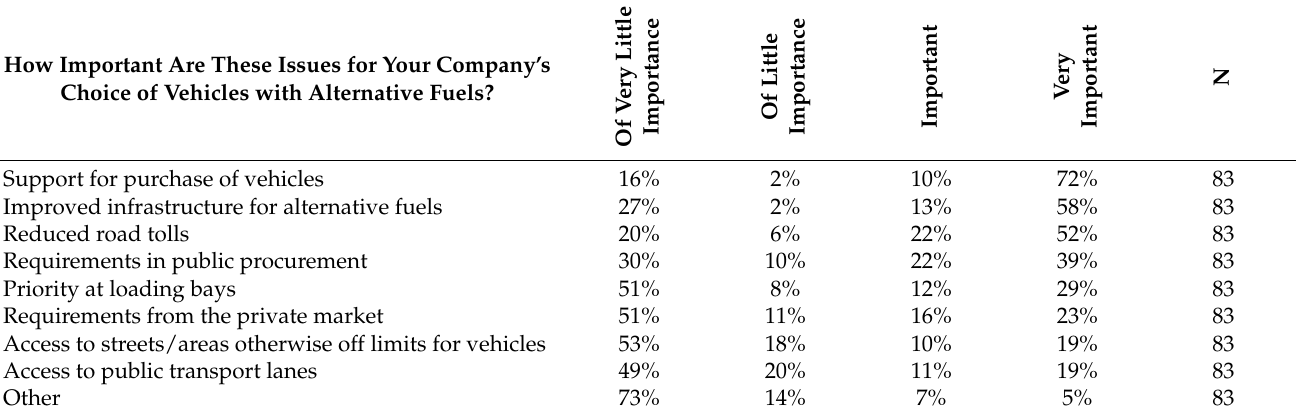
Table 10. Freight service providers’ (FSP) assessment of what affects the company’s acquisition of alternative